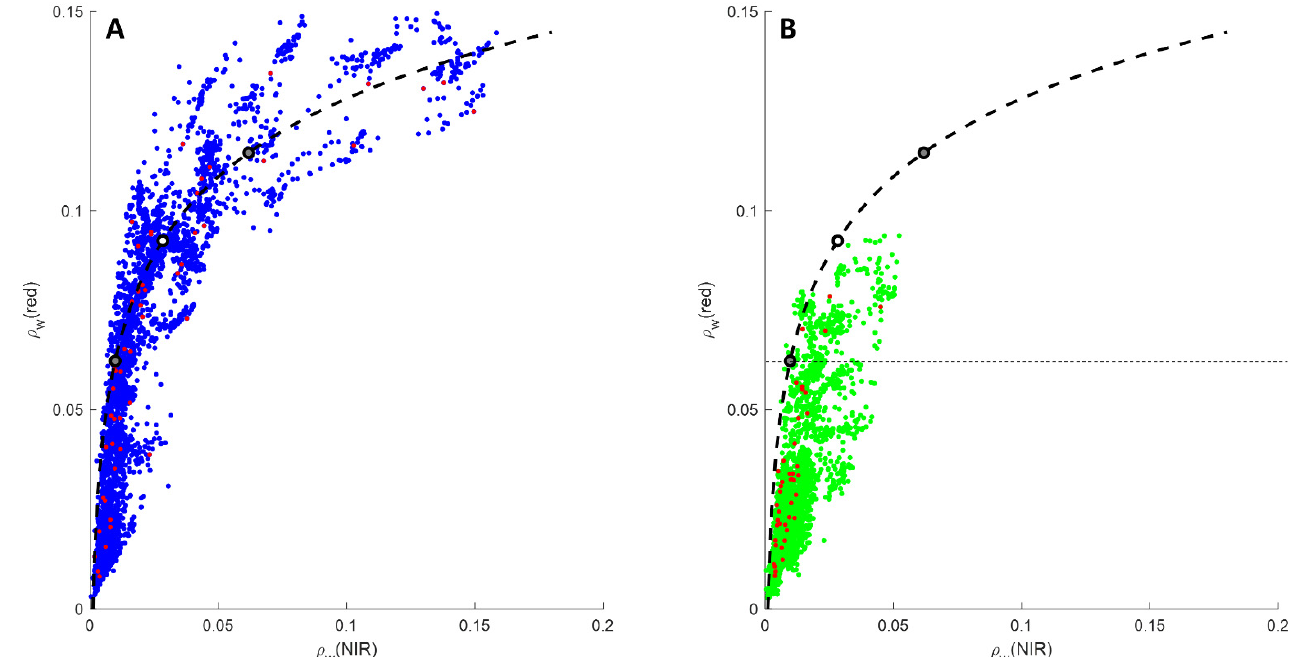
Figure A4. ρ (NIR) vs. ρ (R) relationships for transects extracted from OLI and MSI images (Figure A5) acquired from ( A ) October to March (blue points) and ( B ) April to September (green points). Red points correspond to the transect point extracted at the SORA station. The logarithmic curve and saturation interval boundaries computed in Figure A3 are reported. We clearly see that data points acquired in fall and winter as well as most of data points acquired at the SORA station follow the modeled logarithmic curve, while the data points acquired during spring and summer show a higher scatter due to abnormally high values of ρ (NIR), likely due to adjacency effects. Notice that SPM concentrations for data points with ρ (R) below the horizontal dashed line on B are computed using only the red band relationship and are thus weakly or not affected by this effect.